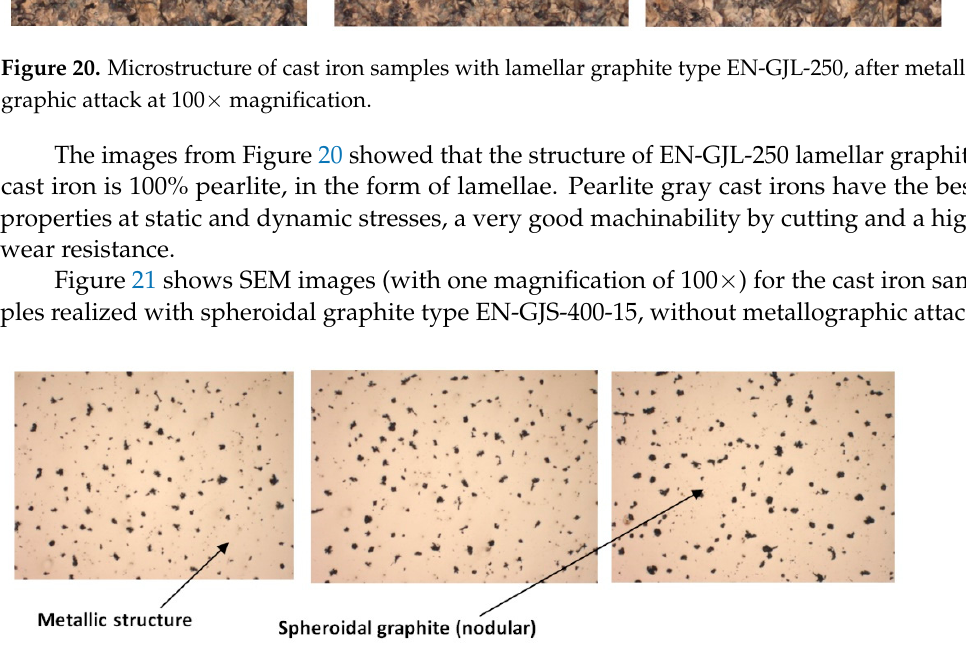
Figure 21. Microstructure of cast iron samples with spheroidal graphite type EN-GJS-400-15, without metallographic attack at 100× magnification.